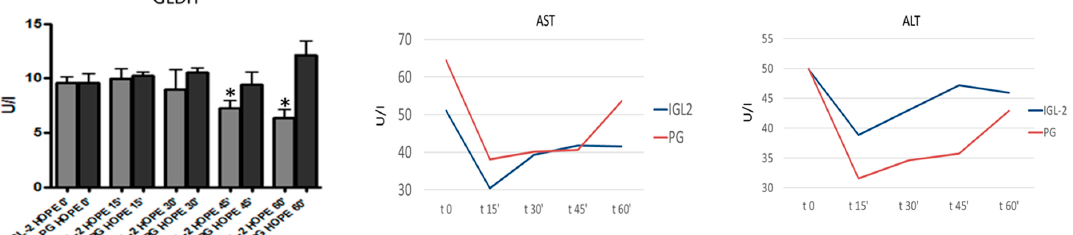
Figure 3. Comparison of Belzer MPS and IGL-2 in HOPE. ( a ) Mitochondrial damage as GLDH activity in fatty livers preserved for 7 h at 4 °C and analyzed for 1 h (measured in 15 min intervals) of HOPE in IGL-2 solution (PEG35-enriched IGL-1 solution) and Perf-gen solution. ( b ) AST/ALT levels during HOPE. Significant differences were found in mitochondrial damage at 40 min and 60 min of HOPE between the two solutions. However, this did not affect AST/ALT levels during the same period. * p < 0.05 represent significant differences vs. Perf-gen group (PG-HOPE).